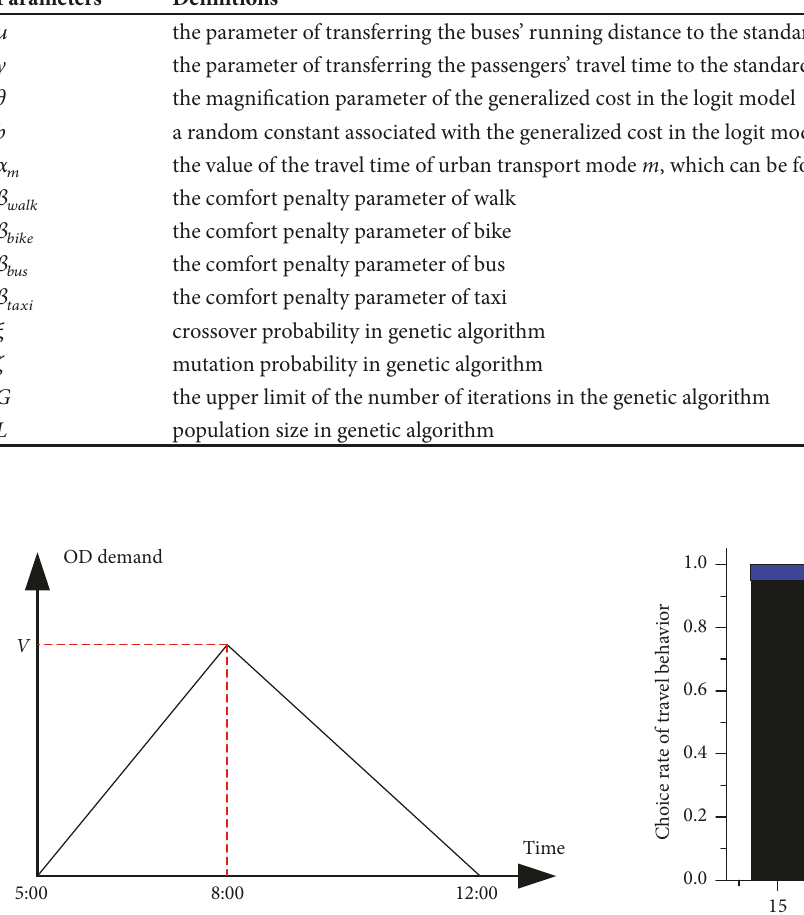
Figure 9: The OD passenger flow demand over time.